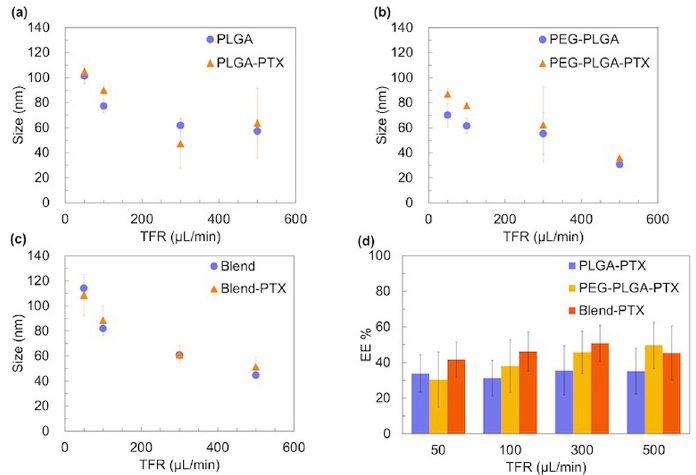
Fig 5. Size of blank NPs, PTX-loaded NPs, and EE of PTX. (a) PLGA NPs and PTX-loaded PLGA (PLGA-PTX) NPs; (b) PEG-PLGA NPs and PTX-loaded PEG-PLGA (PEG-PLGA-PTX) NPs; (c) blend NPs and PTX-loaded blend (blend-PTX) NPs. The purple dots represent blank NPs, and the orange dots are PTX-loaded NPs; (d) EE of PTX prepared at TFR of 50, 100, 300, and 500 μ L/min and the FRR of 3. The error bars represent the standard deviations calculated from the repeated NP preparation experiment at least three